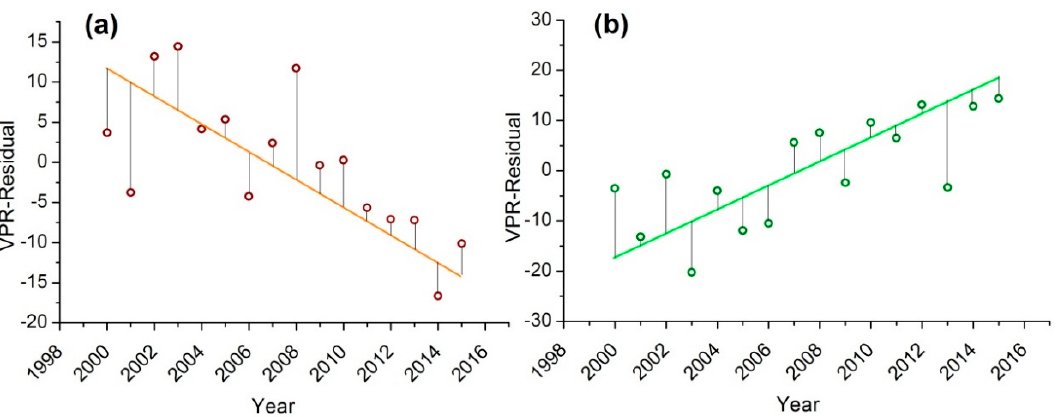
Figure 4. Ordinary least-squares (OLS) linear regression between the vegetation-precipitation relationship (VPR) residual and time: ( a ) a negative trend and ( b ) a positive trend in VPR residual.